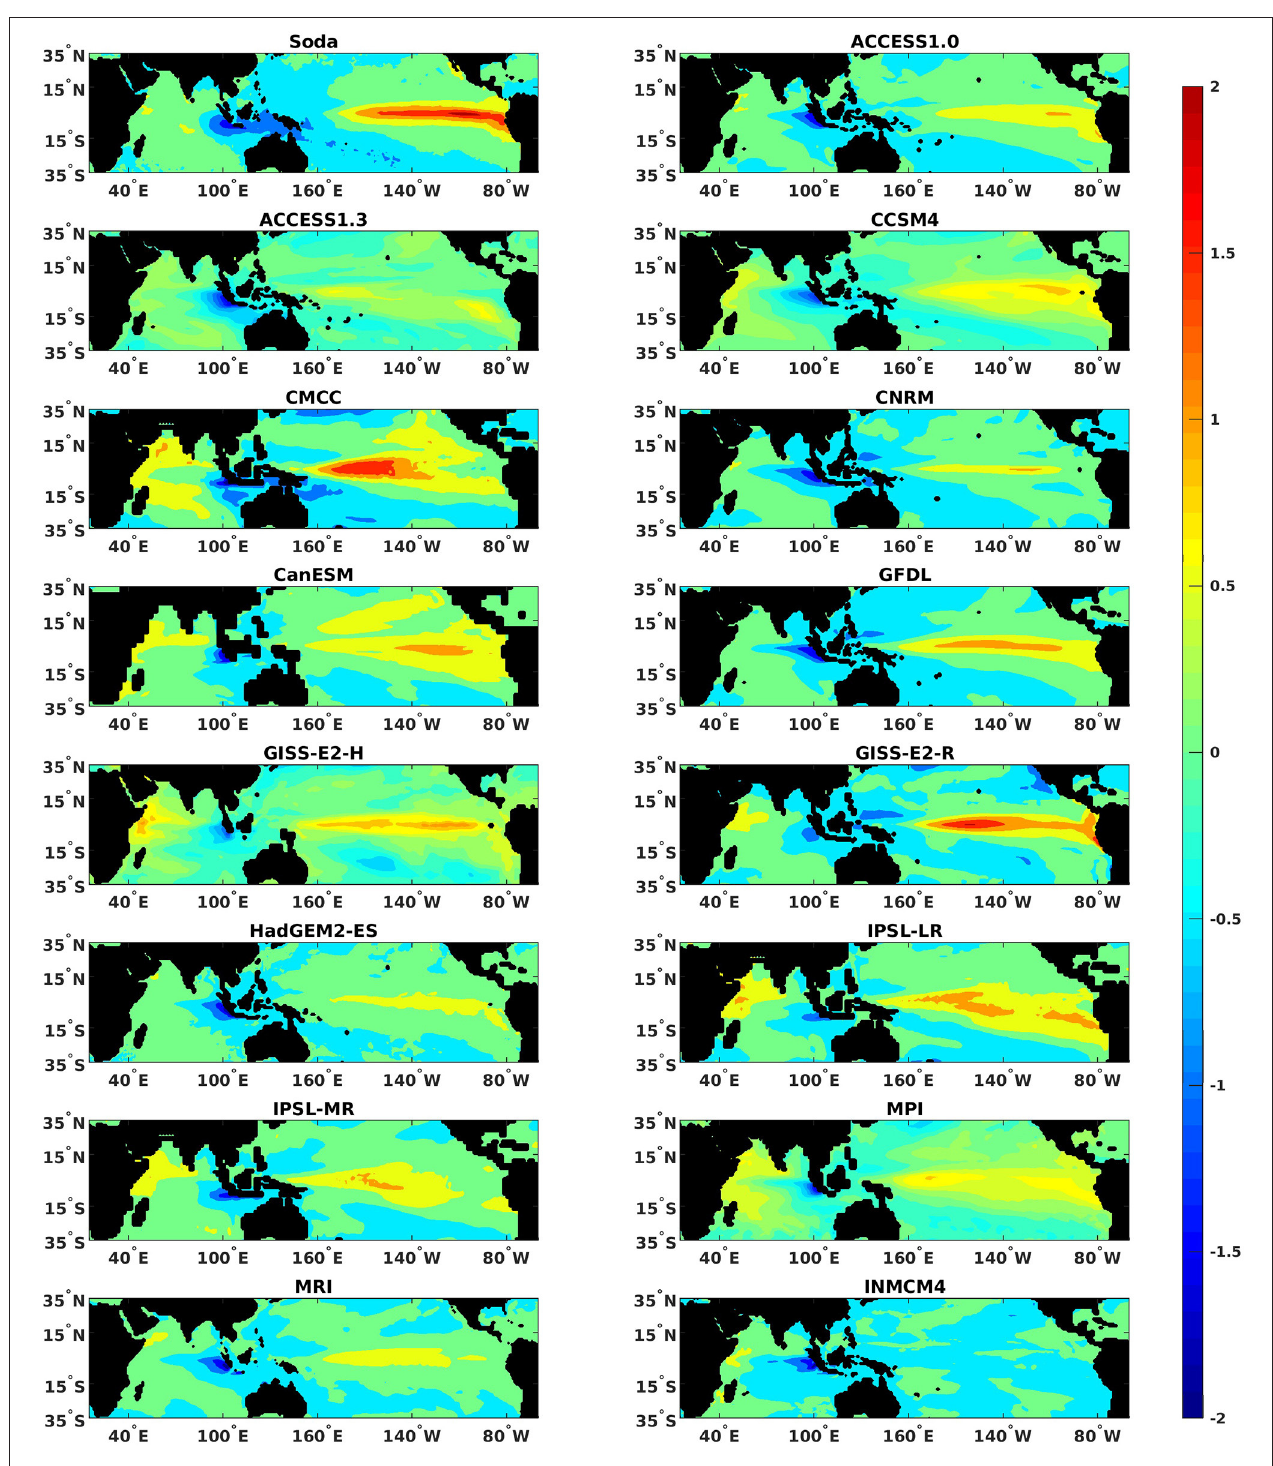
FIGURE 11 | Regression maps of tropical Indo-Pacific sea surface temperatures on the IOD during the extended boreal fall season (ASON) of 1967–2005 for models and 1980–2018 for SODA reanalysis.